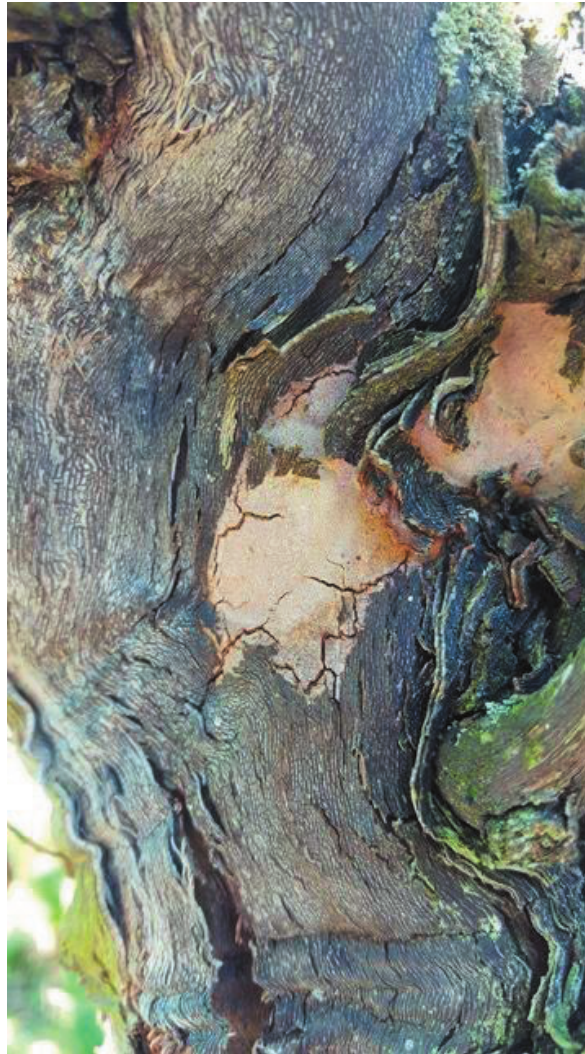
Figure 2. Fruiting bodies of Fomitiporia mediterranea on a grape- vine trunk. Photograph taken in July 2018, from ‘Sauvignon Blanc’, in a vineyard in Ehrenkirchen, Germany.